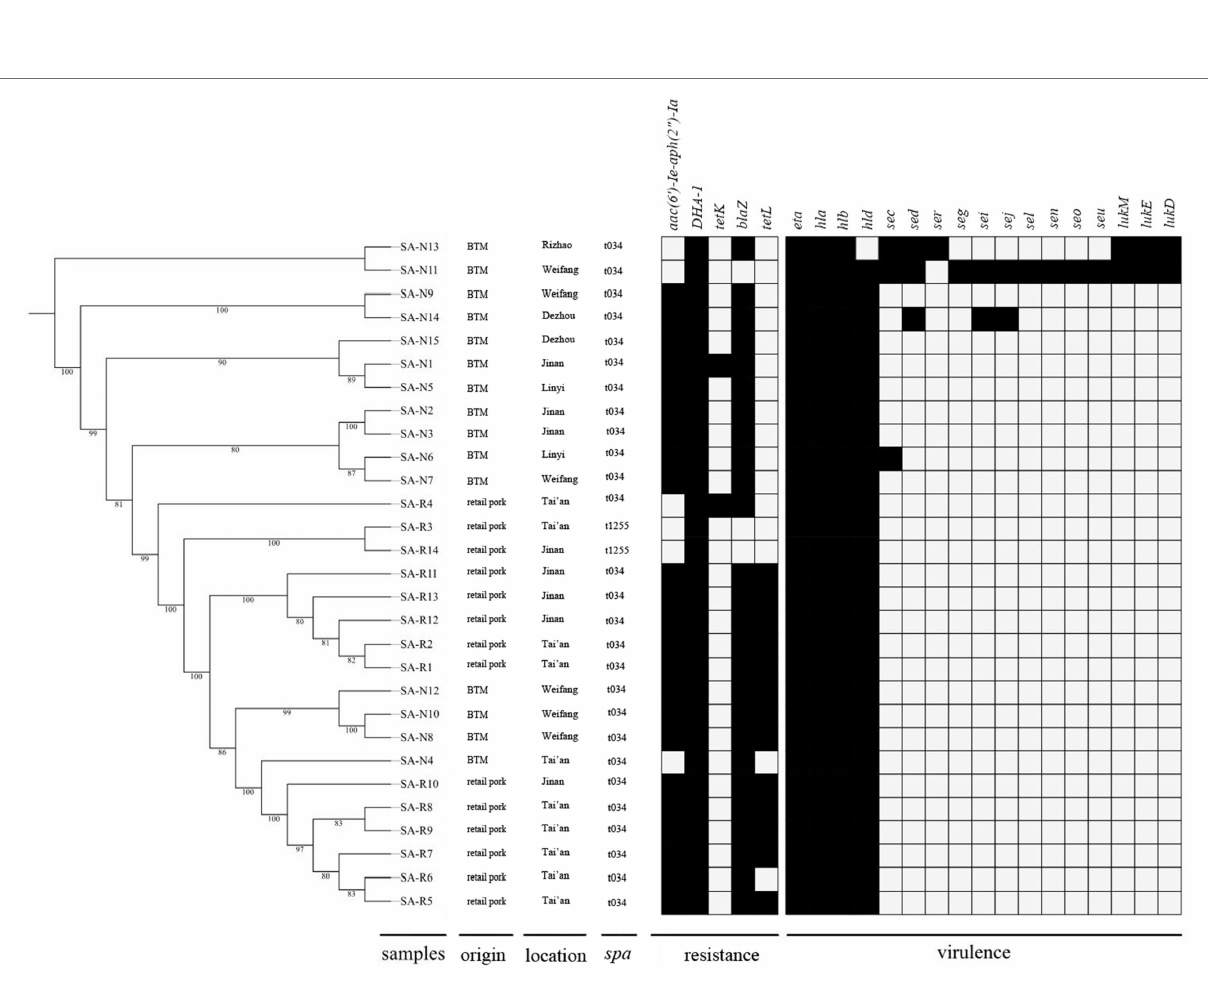
FIGURE 2 | The distributions of the virulence and resistance genes identified in the 29 MSSA ST398 isolates from retail pork and